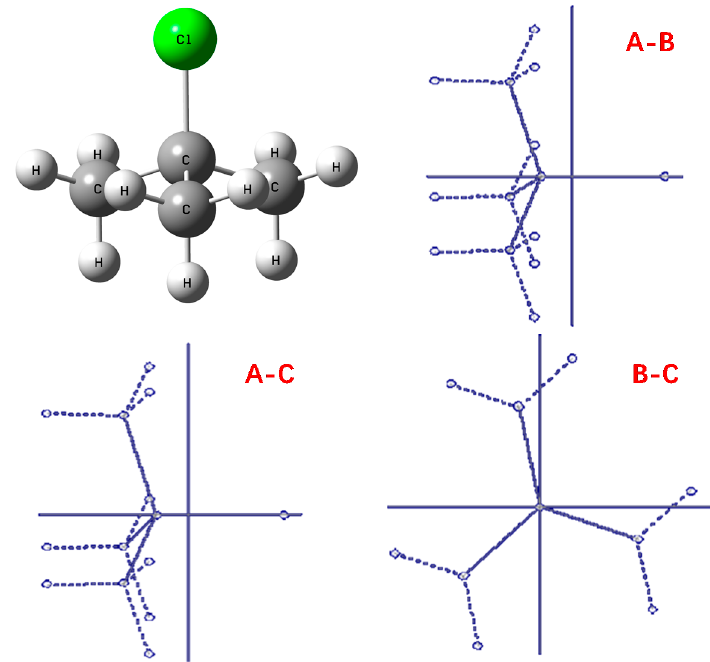
Figure 2. Three-dimensional structure diagram (upper left) and plane projection (A-B, A-C, B-C) of tert-butyl chloride calculated by Gaussian03 software at the MP2/6-311++G (D, P) theory level. Table 1. The rotational constant, moment of inertia and rotational angular momentum of (CH 3 ) 3 C 35 Cl,